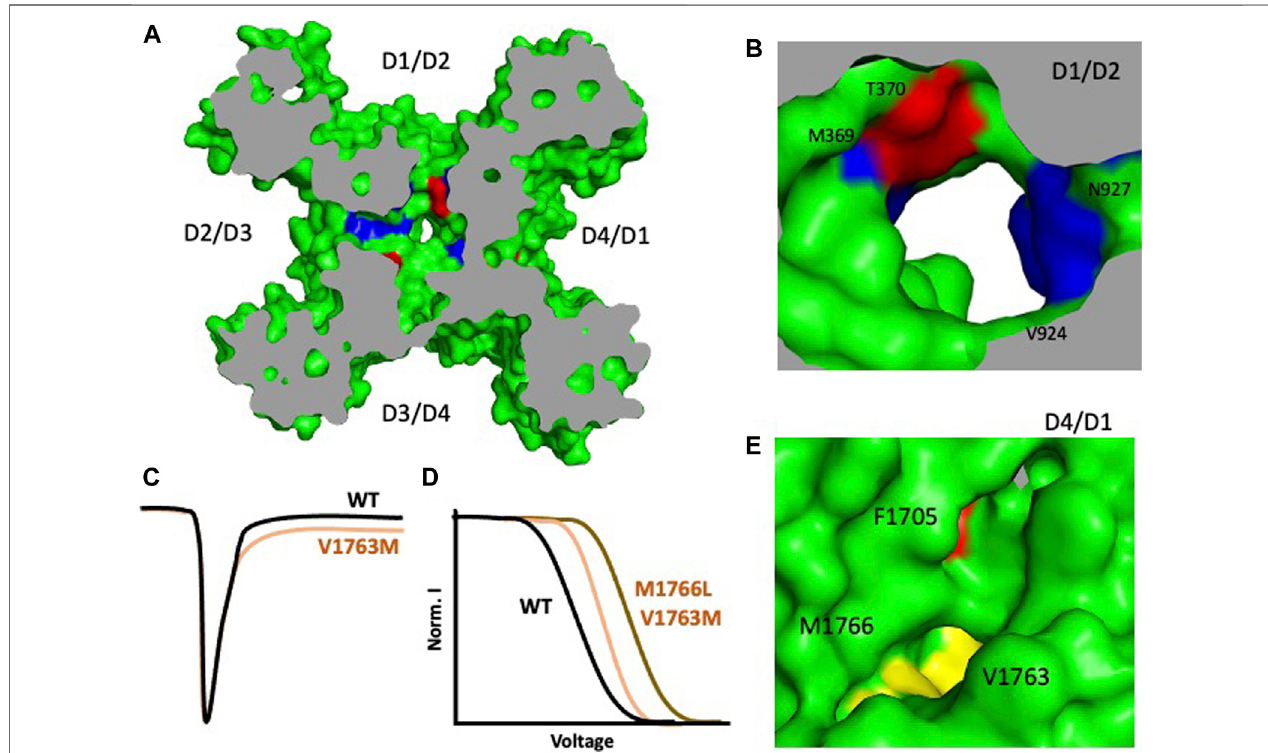
FIGURE 4 | Some arrhythmia mutations in hNa v 1.5 mapped to the channel ’ s fenestrations. (A) Overall structure of hNav1.5 shows the fenestropathy mutations. LQT3 mutations are shown in red, Brugada syndrome mutations in blue, and mutations which cause mixed phenotype are shown in yellow. (B) D1/D2 fenestration shows four residues that cause LQT3 and Brugada syndrome. (C) V1763M leads to late sodium current (D) M1766L causes a signi fi cant shift in the steady-state inactivation pro fi le. (E) D4/D1 fenestration shows F1705S, V1763M, and M1766L (Li Z. et al., 2021).